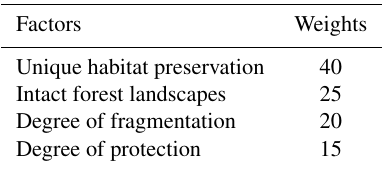
Table 4. Criteria for assigning ecoregions within biomes to the dif- ferent